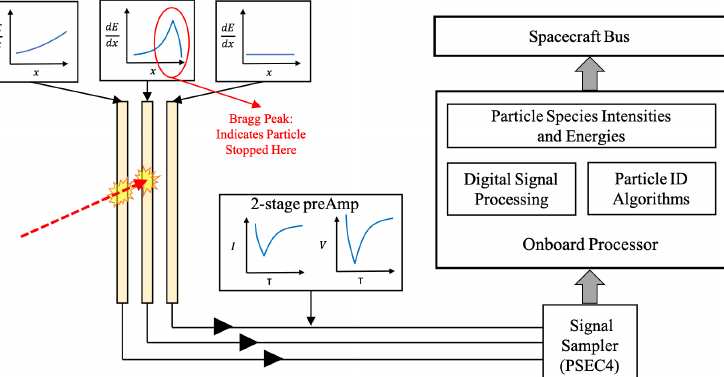
Figure 5. Simplified schematics of AGILE’s processing of signals produced by interacting particles. In the represented case, the particles stop in the second layer.